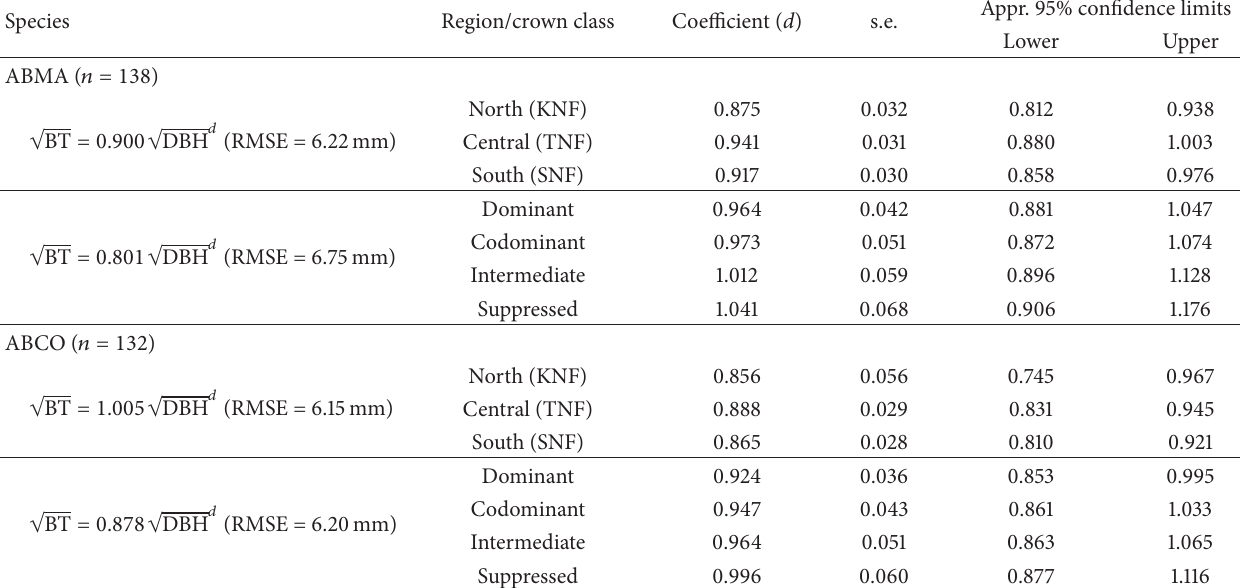
Table 2: Comparison of bark thickness (BT; mm) as a function of DBH (cm) across latitudinal gradient (north, central, south) and among crown classes (dominant, codominant, intermediate, and suppressed) for red fir (ABMA) and white fir (ABCO) at Klamath National Forest (KNF), Tahoe National Forest (TNF), and Sequoia National Forest (SNF). Coefficients and fit statistics for region and crown class dummy variable ( d ) in nonlinear regression.